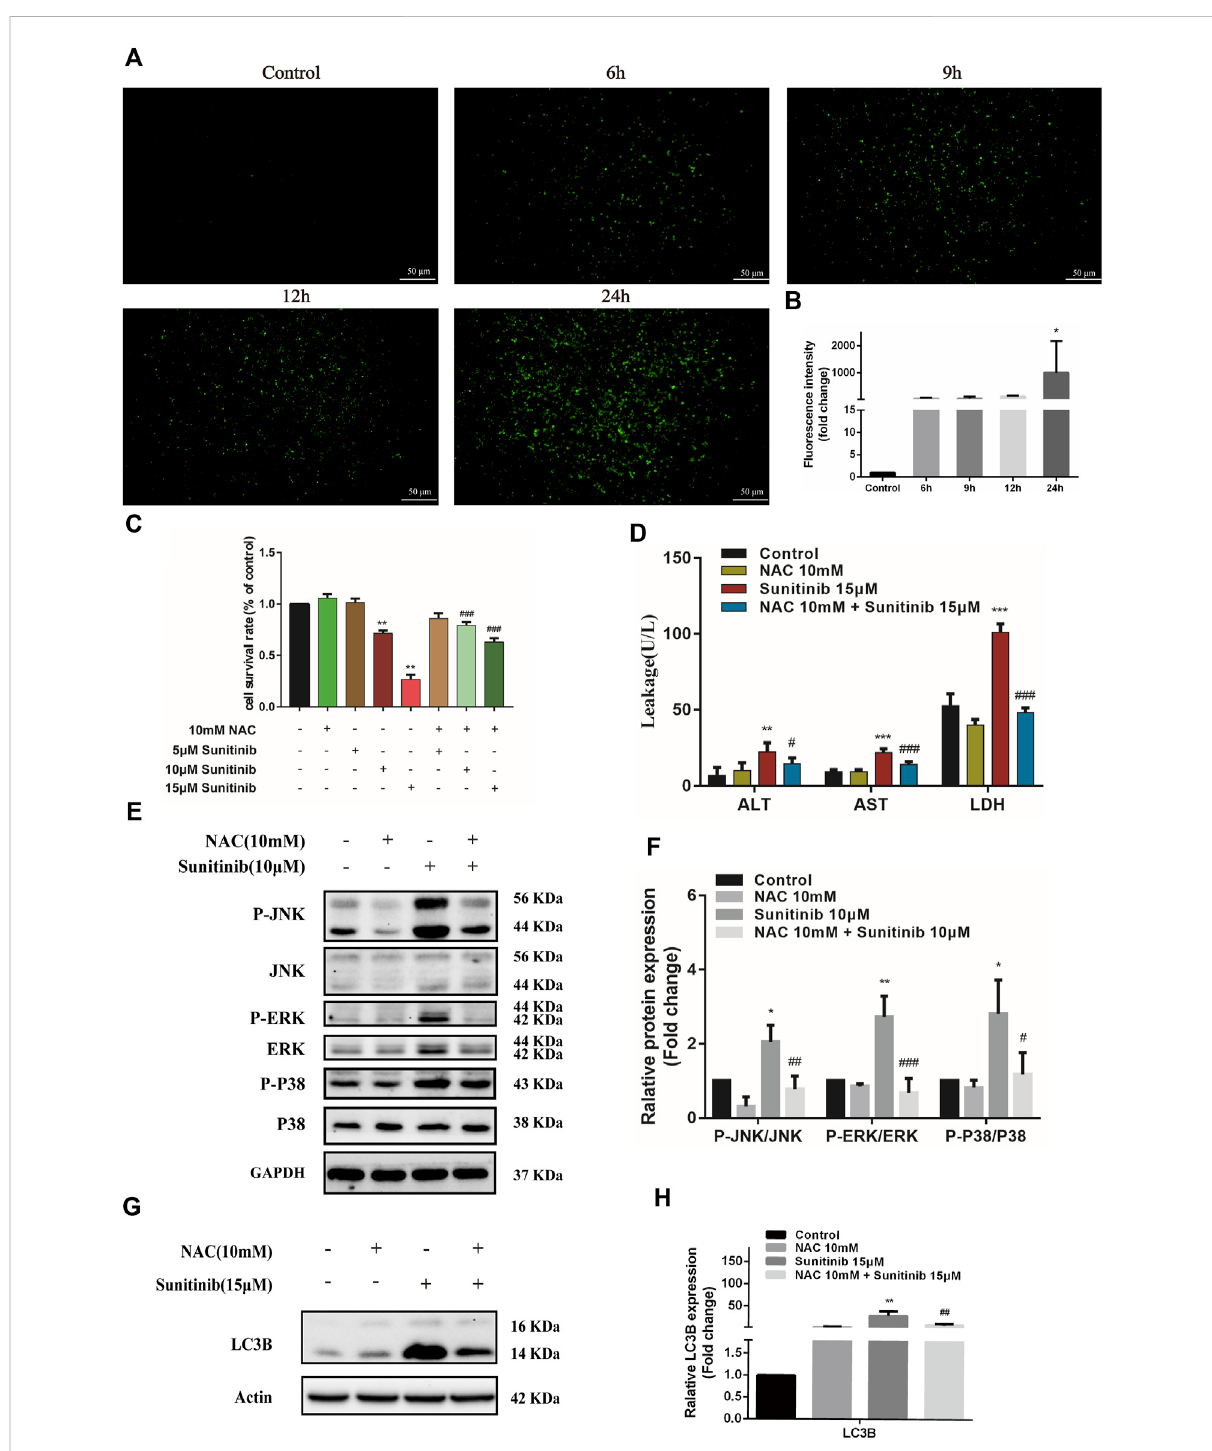
FIGURE 5 SunitinibinducesexcessiveROSwhichactivatesMAPKs,therebyinducingapoptosisandautophagyinL02cells. (A) L02cellswereexposedwith Sunitinib at 15 μ M for 6, 9, 12, 24 h. ROS levels were analyzed using a ROS assay kit. Green fl uorescence was observed on fl uorescence microscopy (scale bars = 50 μ m). (B) Quanti fi cation of ROS intensities. (C) The viability of hepatocytes was analyzed by MTT after L02 cells were incubated with 5 μ M,10 μ M,and15 μ MSunitinibfor48 hinthepresenceorabsenceof10 mMNACpretreatmentfor6 h( n =6). (D) ALT,AST,andLDHlevelsin the supernatant after L02 cells were incubated with 15 μ M Sunitinib for 48 h in the presence or absence of 10 mM NAC pretreatment for 6 h ( n = 3). (E,F) Protein expression of p-JNK/JNK, p-ERK/ERK, and p-P38/P38 after L02 cells were incubated with 10 μ M Sunitinib for 12 h in the presence or absence of 10 mM NAC pretreatment for 6 h ( n = 3). (G,H) LC3B levels in L02 cells after Sunitinib (15 μ M) for 48 h in the presence or absence of 10 mM NACpretreatment for6 h( n =3).* p < 0.05,** p < 0.01,and*** p < 0.001vs.Controlgroup. # p < 0.05, ## p < 0.01and ### p < 0.001 vs.Sunitinib